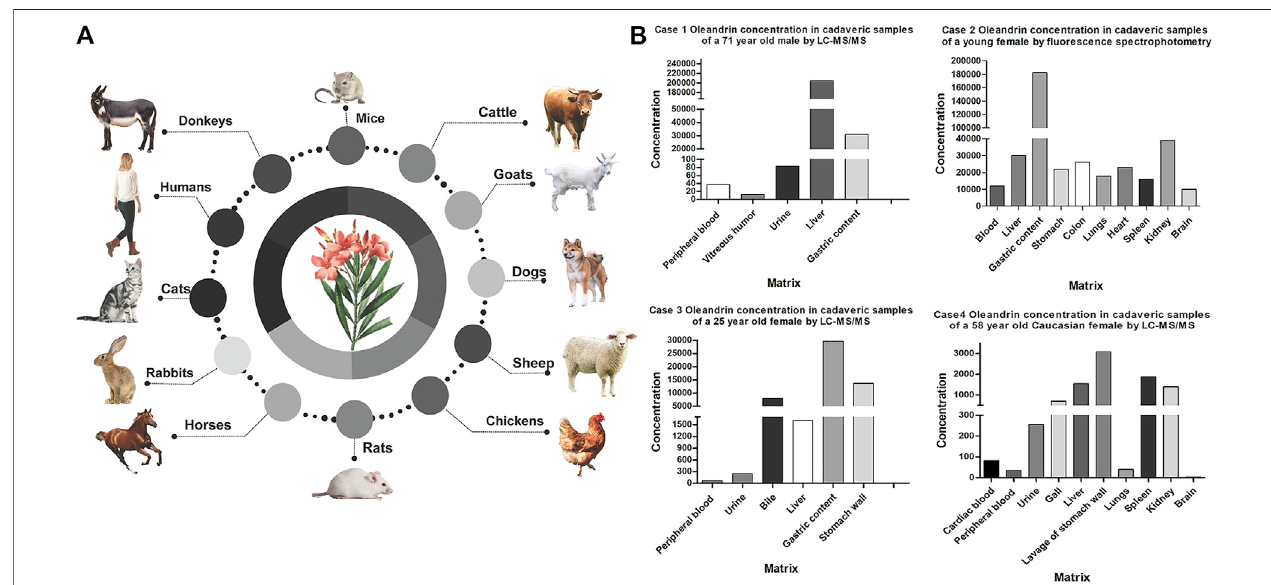
FIGURE 4 | Overview of literature data of the poisoning cases caused by Nerium Oleander. (A) Species involved in oleander poisoning cases. (B) Summary of oleandrin tissue distribution concentration in reported fatal cases of oleander in humans (ng/mL or ng/g).